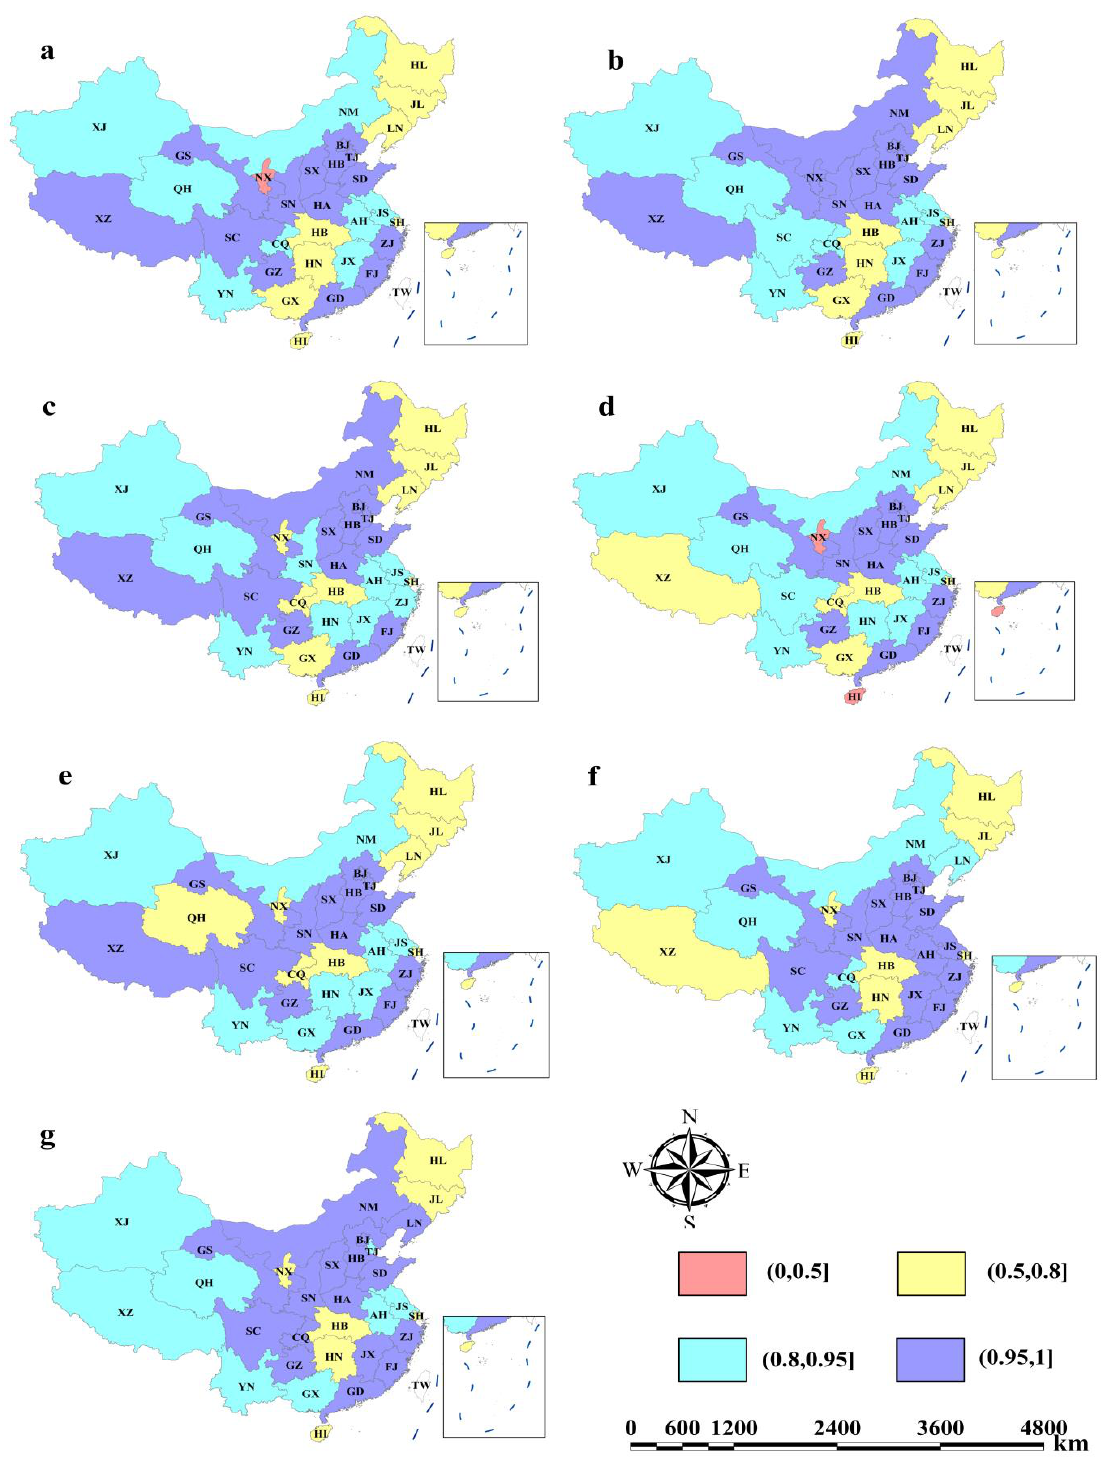
Figure 4. Spatial distribution of the WRM performance in the 31 provinces of China from 2013 to 2019 (( a – g ) represents the year 2013 – 2019, respectively).